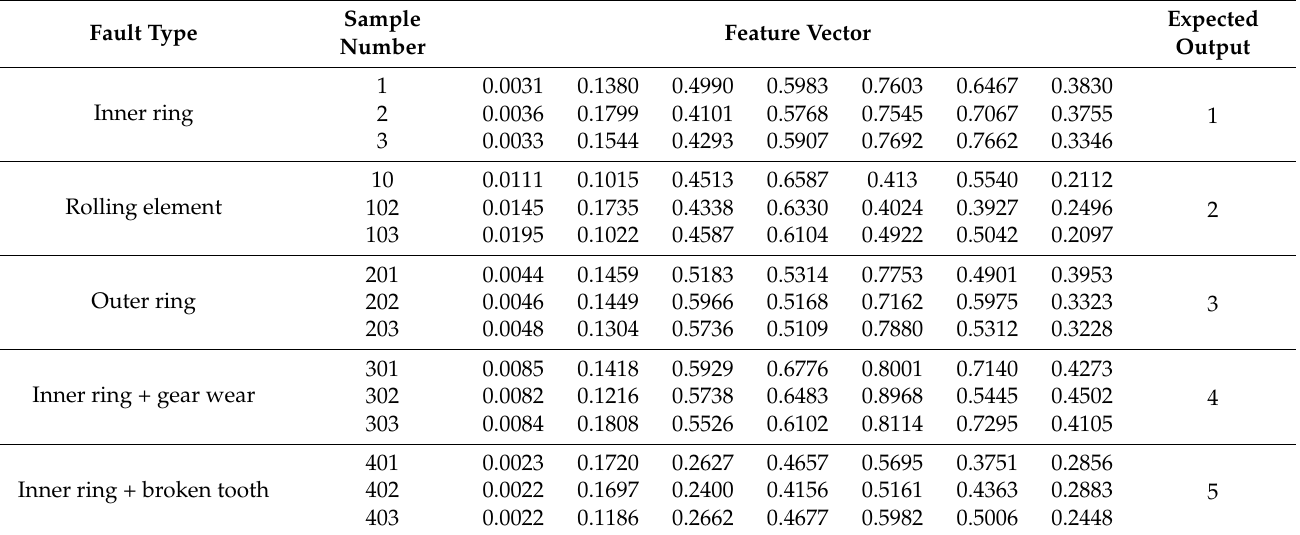
Figure 6. AVMD decomposition and spectrum diagram of inner ring fault signal. Table 5. MFE feature sets for different